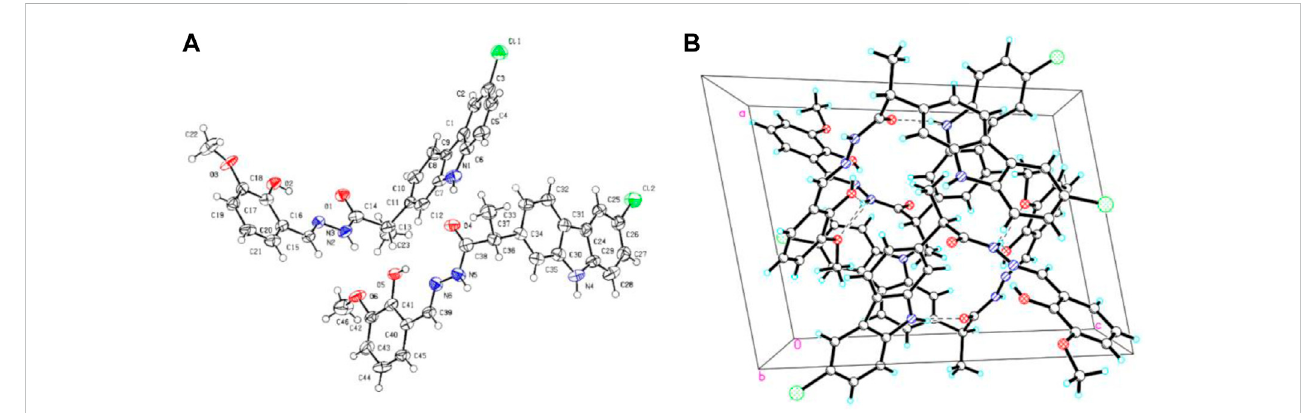
FIGURE 2 Single crystal structure (A) and packing diagram (B) for compound 14a , and the dashed lines denote intermolecular hydrogen